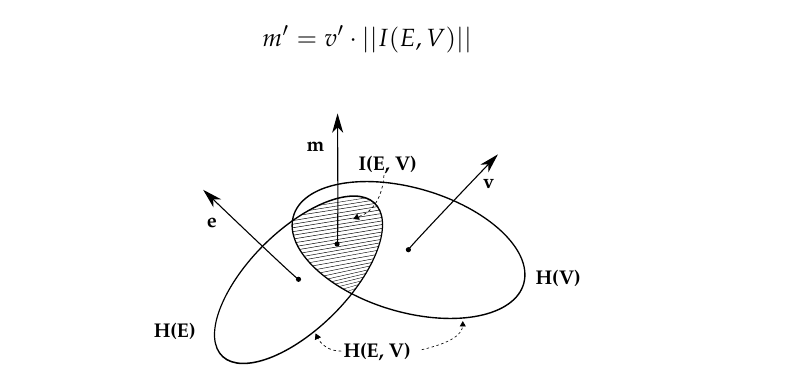
Figure 4. Illustration of shared information between Electroencephalography (EEG) and vehicular signal